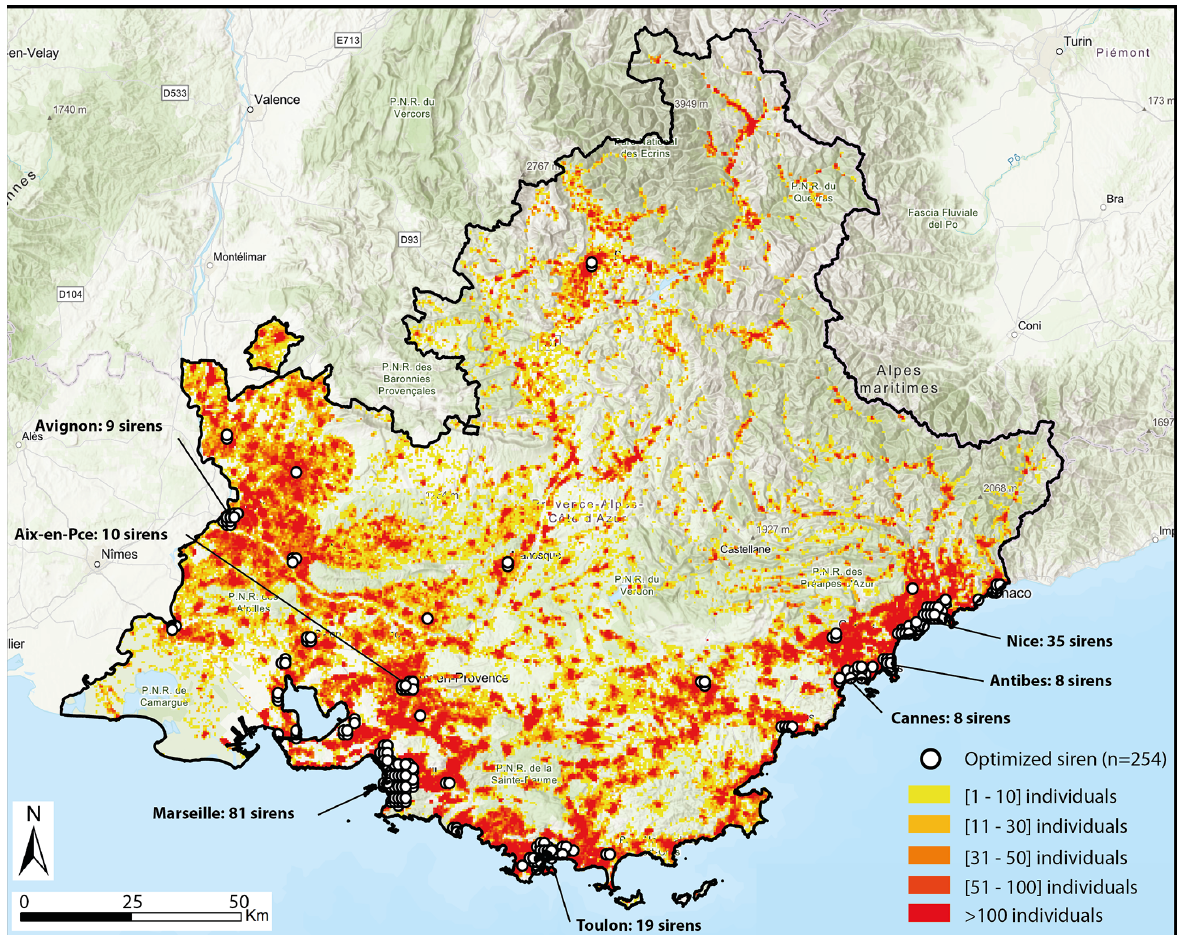
Figure 7. Relocation of the sirens in the PACA region taking into account the most densely populated cities (the current location of the 254 SAIP sirens can be viewed in Fig. 4). DEM layer (public data) was only reused as the background map.